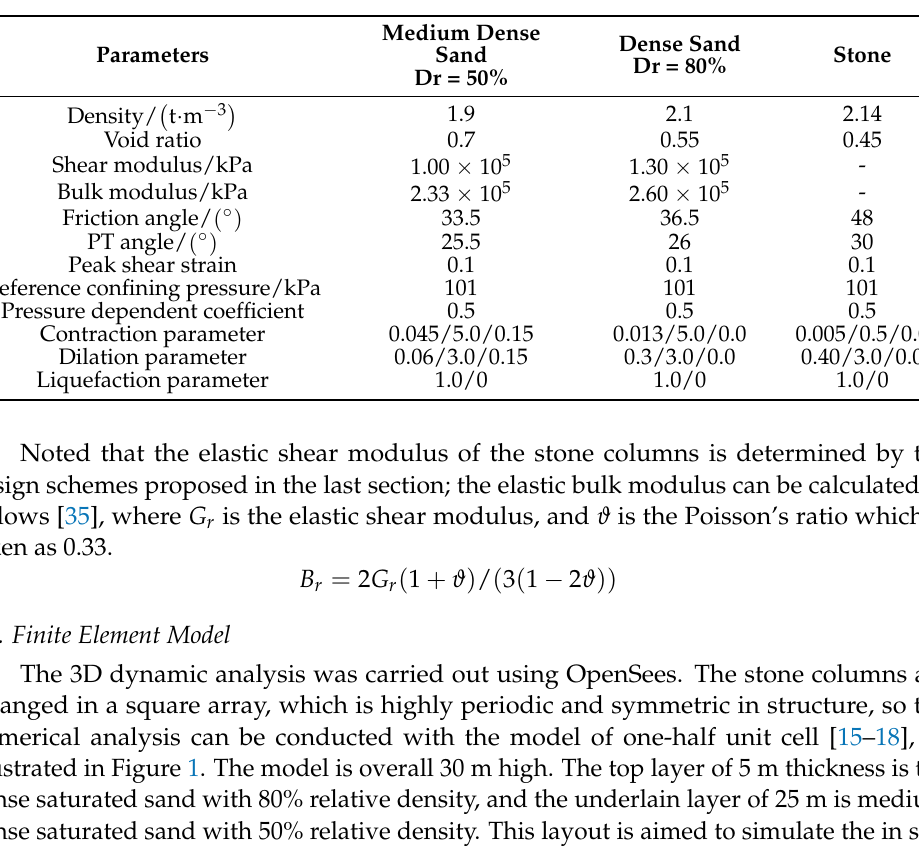
Table 3. Parameters of PDMY02